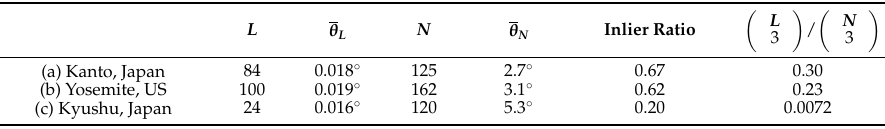
Remote Sens. 2017 , 9 , 90 Table 3. Numbers of matched feature pairs and averaged θ s before and after RANSAC. Here, N is the numbers of all pairs extracted by rough matching and L is the number of feature pairs surviving the RANSAC filtering. Inlier ratio and (cid:4672)(cid:1838) 3(cid:4673)/(cid:4672)(cid:1840) 3(cid:4673) are also provided. Note that the result here was the same for any of the four RANSAC-based algorithms.